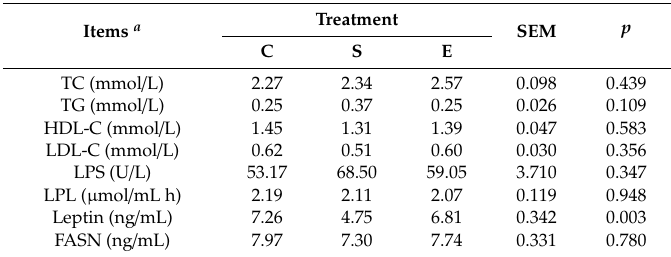
Table 4. The e ff ects of mulberry leaves on serum biochemical